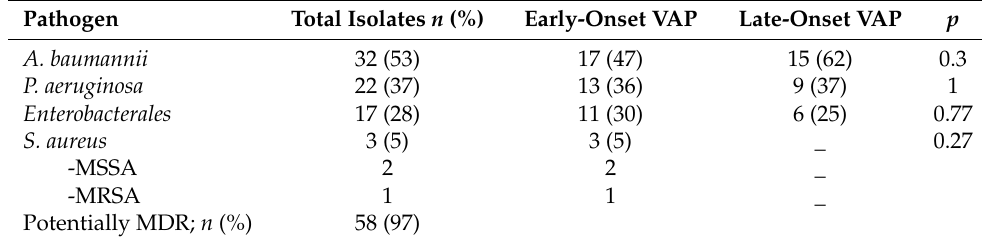
Table 3. Organisms isolated from early- and late-onset VAP cases.